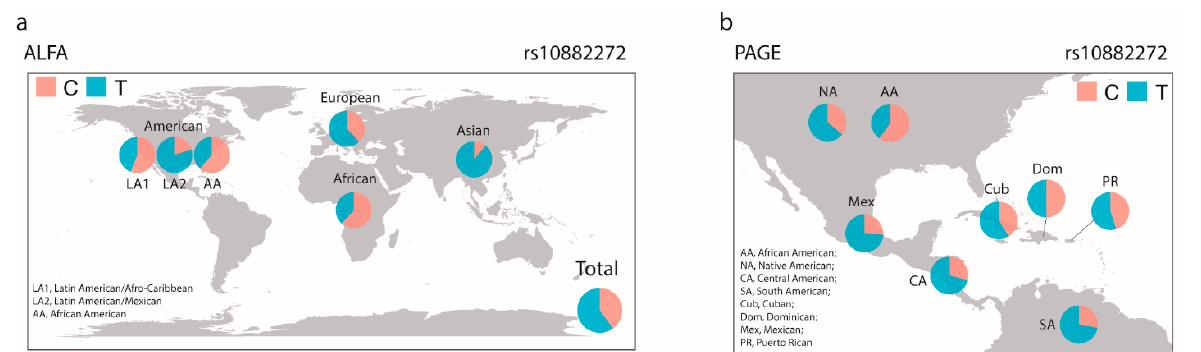
Figure 1. Variations of the allele frequencies of rs10882272. We plotted the allele frequency of each ethnic group ( a ) Allele Frequency Aggregator (ALFA) and ( b ) Population Architecture using Genomics and Epidemiology (PAGE). C, rs10882272 C allele; T, rs10882272 T